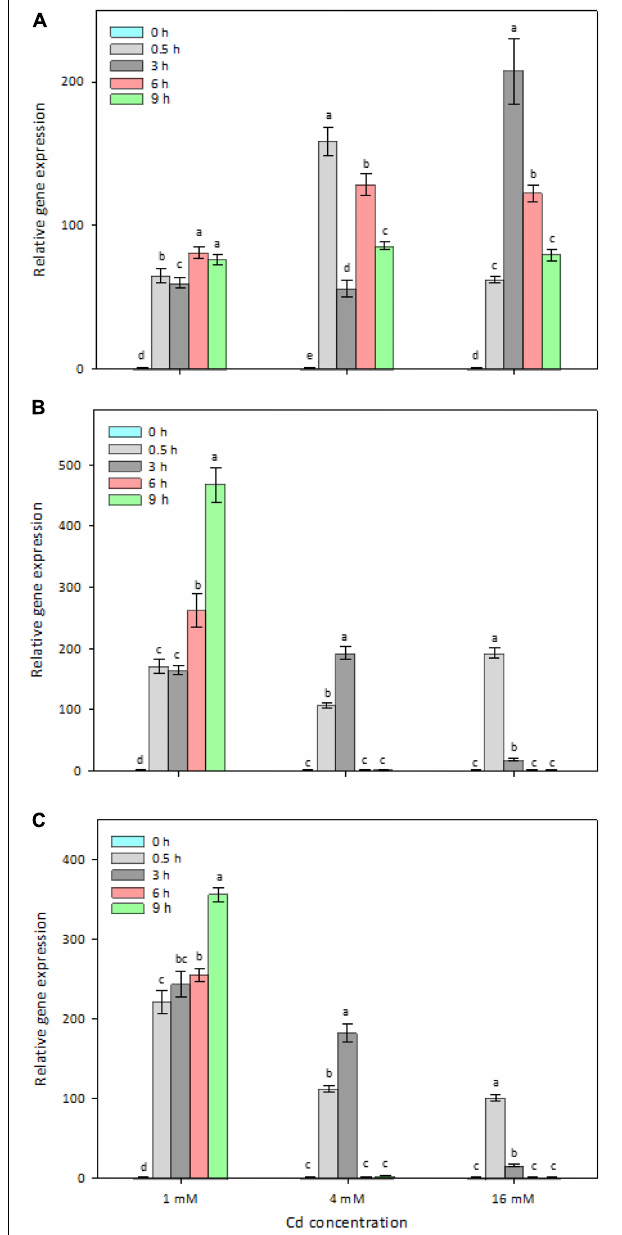
FIGURE 5 | Time-dependent and Cd-level-dependent responses of the Cd-inducible metal resistance genes. (A) zntAY8 ; (B) copAY8 ; (C) HMTY8 .